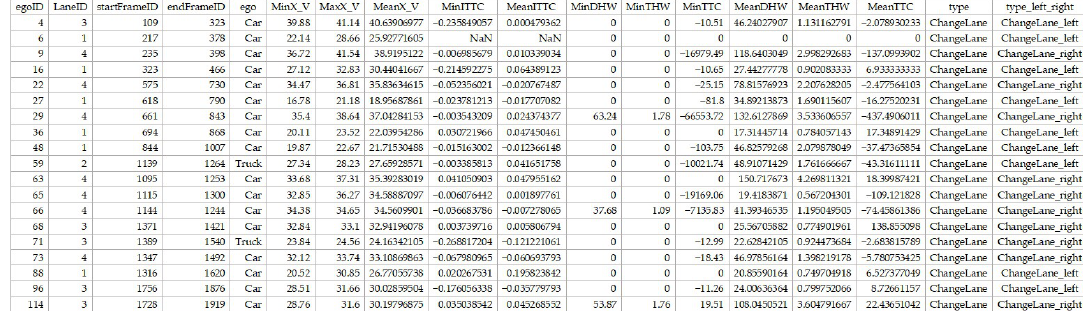
( b ) Lane-changing Distance density Figure 6. Duration and distance density map of lane-changing segments.